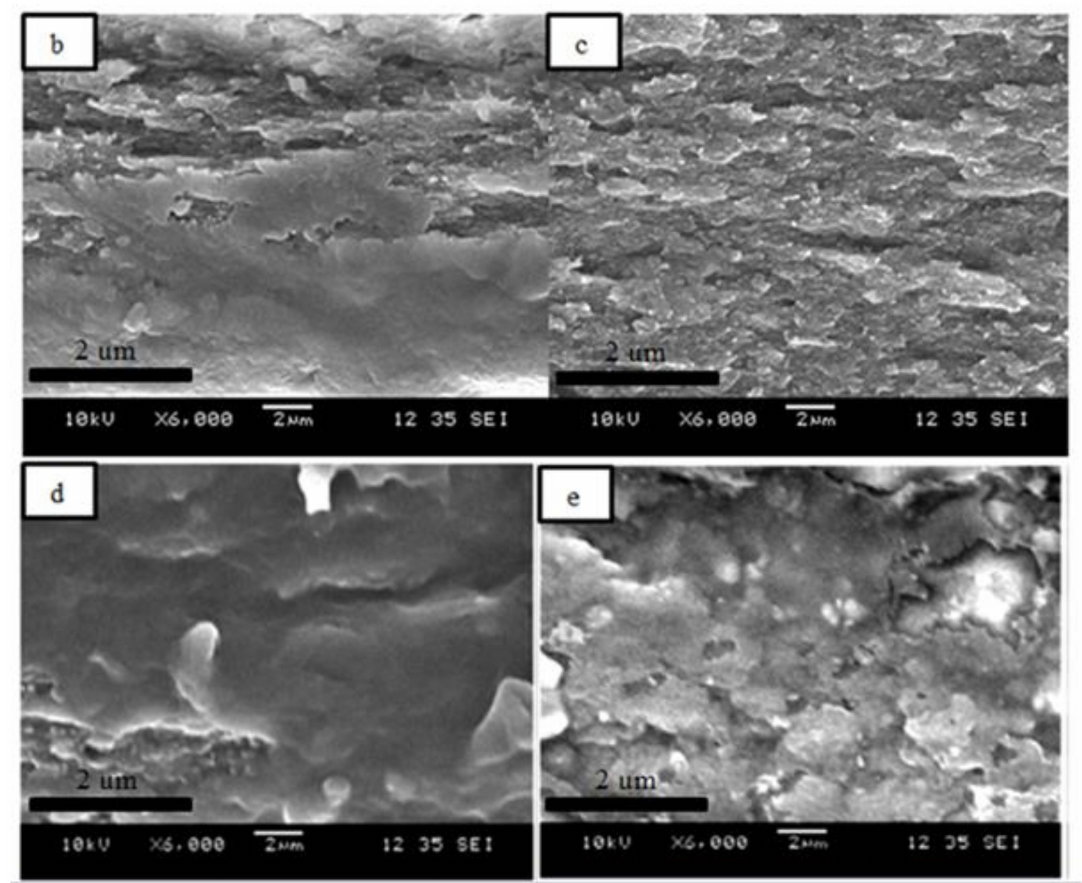
Figure 6. ( a ) SEM of EFB powder. Tensile fractured surface of ( b ) untreated RC biocomposite film containing 2 wt% EFB, ( c ) untreated RC biocomposite film containing 4 wt% EFB, ( d ) treated